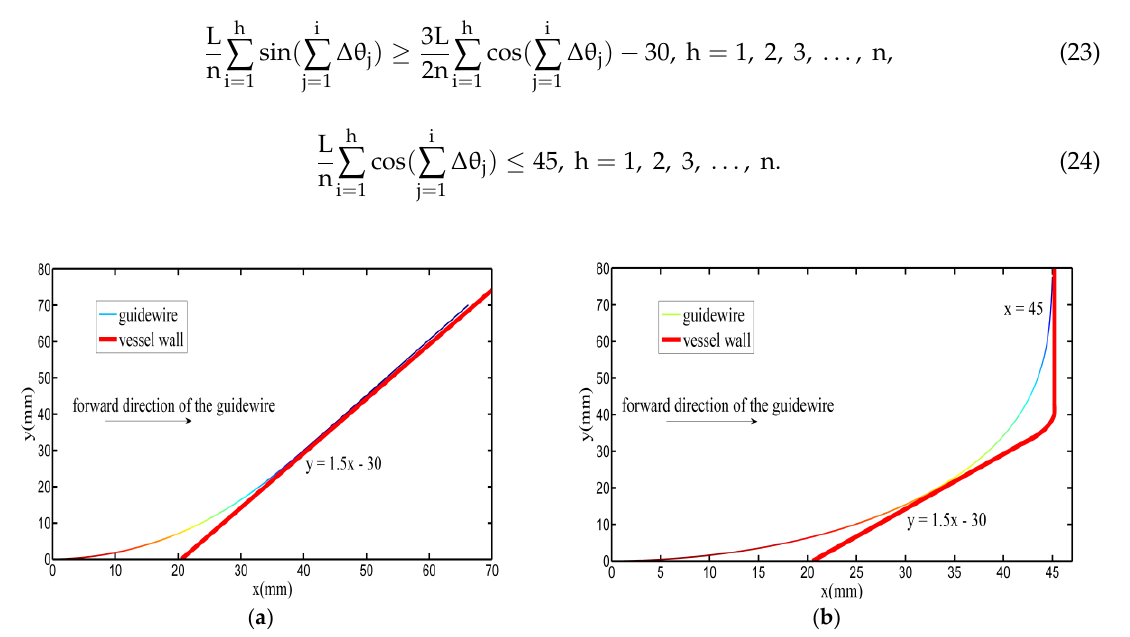
Figure 6. Optimized guidewire shapes for different contact conditions. ( a ) The equation for an oblique vessel wall is y = 1.5 x − 30; ( b ) The equation for a vertical vessel wall is x = 45.